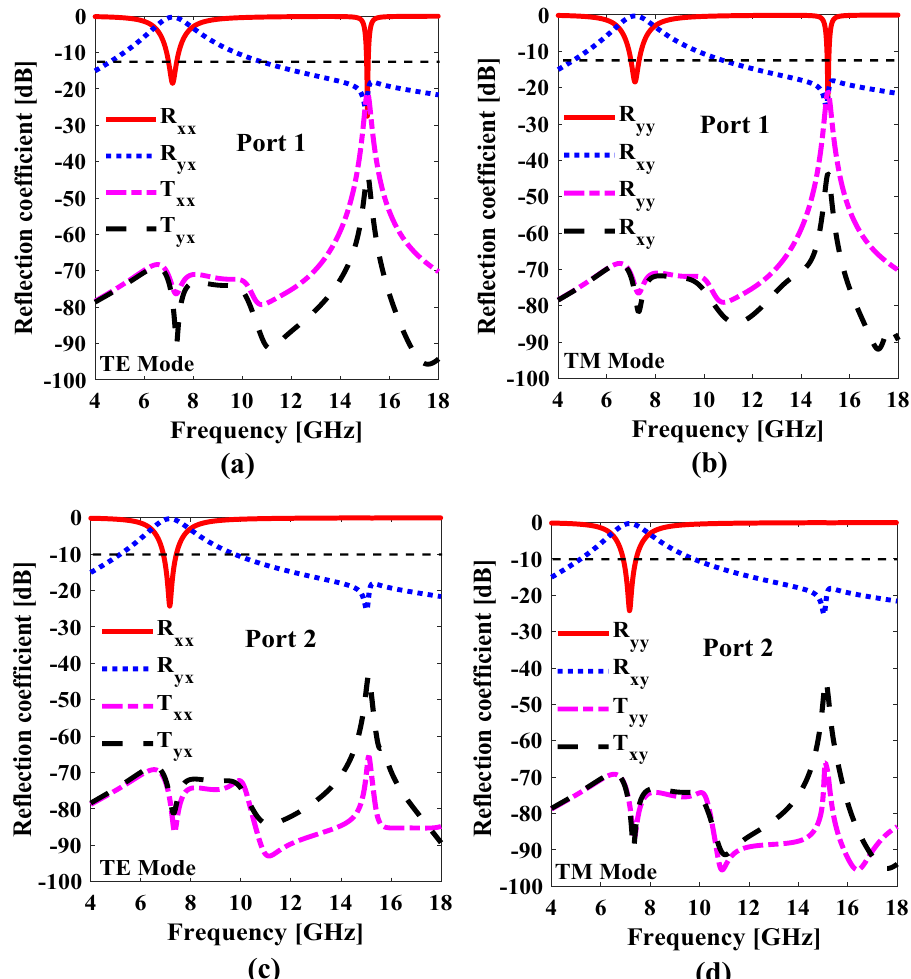
Figure 5. Transmission and reflection coefficients of proposed metasurface ( a ) TE mode for port 1 ( b ) TM mode for port 1 ( c ) TE mode for port 2 ( d ) TM mode for port 2. *The figure is created using MATLAB ver. R2020A-URL: https:// www. mathw orks. com/ produ cts/ matlab. html.